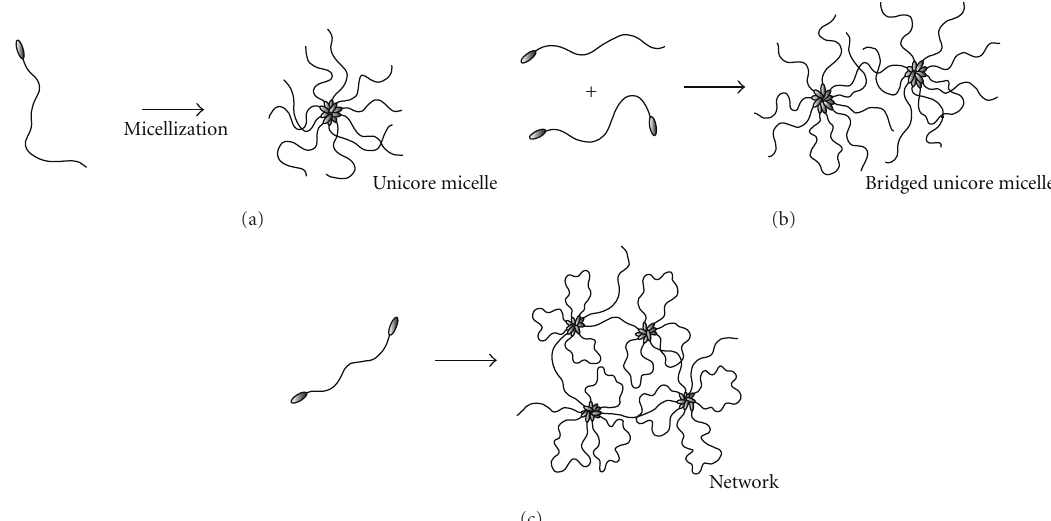
Figure 5: Association of hydrophobically end-modified polymers: (a) singly end-modified polymers; (b) a mixture of singly and doubly end-modified polymers; (c) doubly end-modified